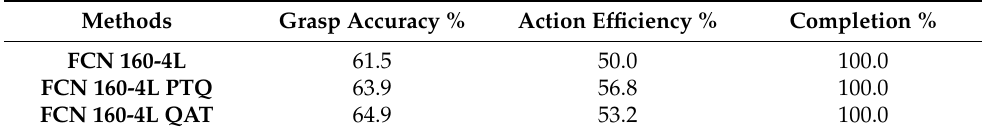
Table 4. Results for real robot setup tested on novel objects challenging scenarios.